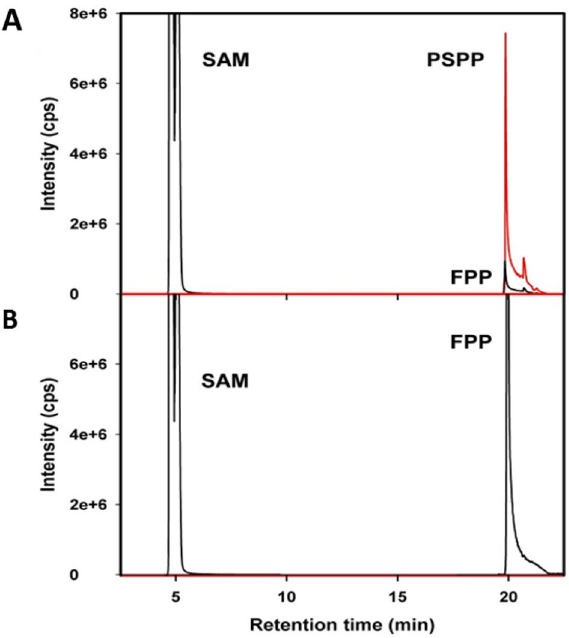
Figure 2. LC–MS separation of SAM, FPP, and putative PSPP in MRM-mode. Mass transitions are given in the method section. Enzyme assays including FPP and SAM were incubated, ( A ) with FPP C -methyltransferase enzyme (FPPMT), ( B ) without FPPMT. FPP and PSPP (red) elute at very similar retention times. Since no PSPP formation was observed in the control ( B ), the formation of PSPP ( A ) is enzyme-dependent. The split peak for SAM is due to detector